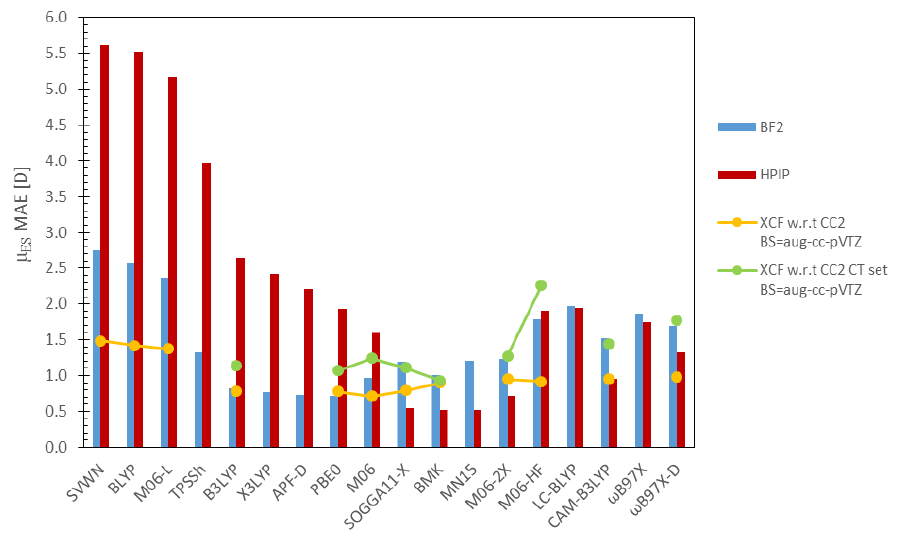
Figure 6. Comparison of DFAs predictive power; data presented in columns concern µ ES calculated in this work, while information displayed as “lines” relate to literature data—yellow, a set of 15 small organic molecules and green, 15 large organic molecules exhibiting CT